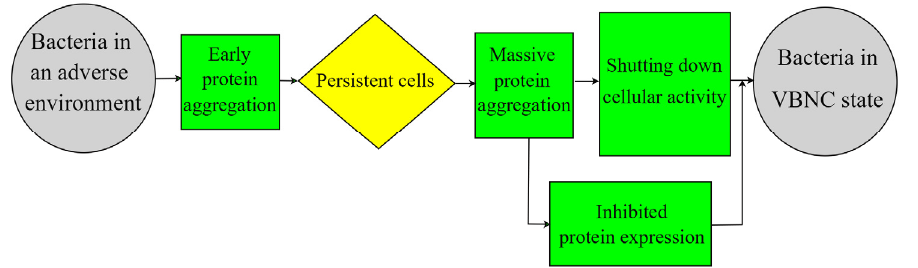
Figure 4. Schematic diagram of protein aggregation regulation